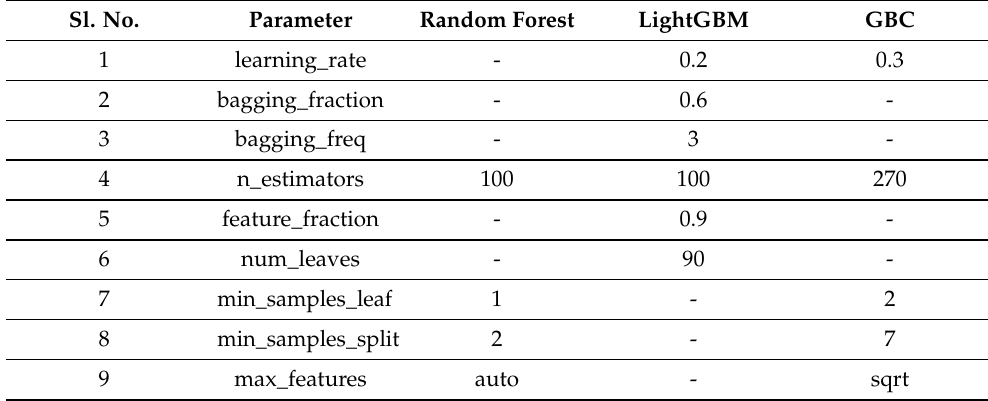
Table 2. Final parameter settings for models. Sl.